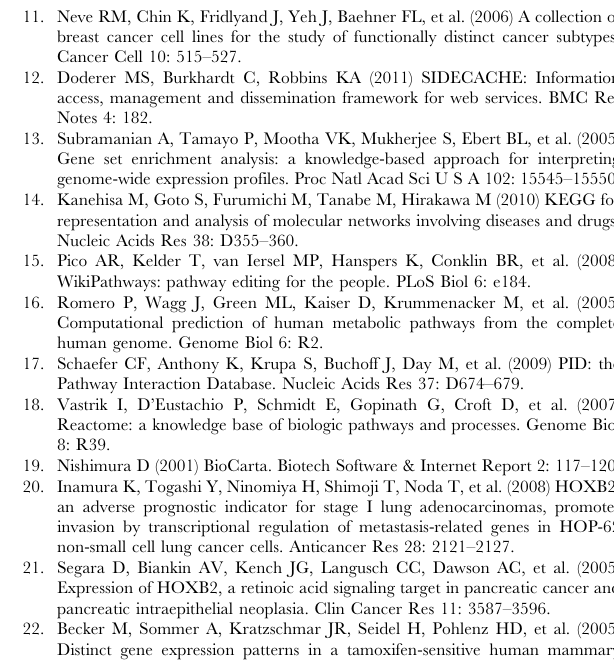
Figure S1 The database (from genome-wide methyla- tion sequencing data of human cancers), web interface